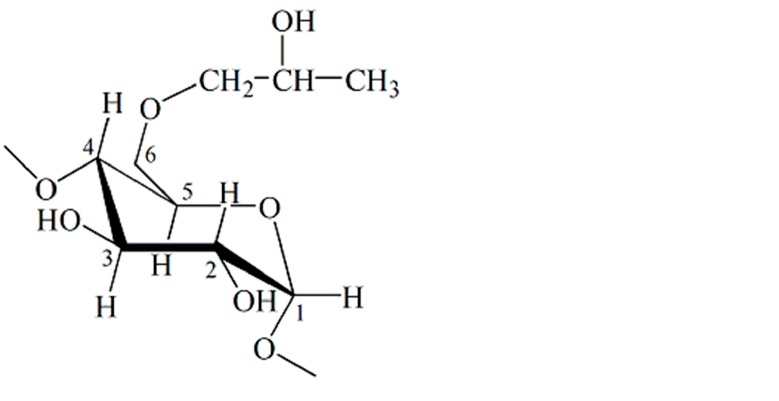
Figure 3. Chemical structure of a seven ‐ membered ring molecule part of 2 ‐ hydroxypropyl ‐β‐ cy ‐ clodextrin. β